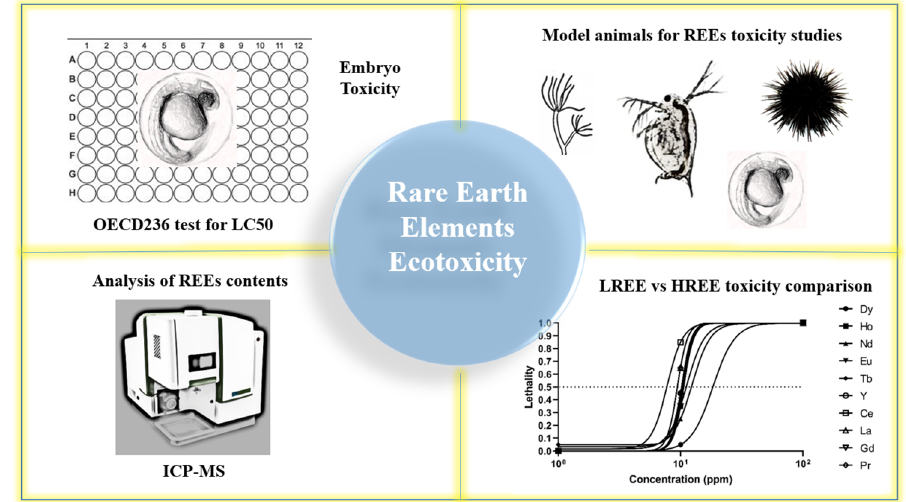
Figure 2. Summary of the fish and other simple animal models that can be used to study rare earth elements (REEs) toxicity. (Upper left panel) zebrafish is suitable to conduct high throughput toxicity assay due to its small size and transparent out looking. (Upper right panel) other animal models like hydra, daphnids, and sea urchin also can be used for the REE toxicity study. (Bottom left panel) inductively coupled plasma mass spectrometry (ICP-MS) provides high sensitivity to detect the bioaccumulation and distribution of REEs in the animal body. (Bottom right panel) the acute toxicity of REEs can be easily measured in zebrafish by calculating the 96-h LC50 value.